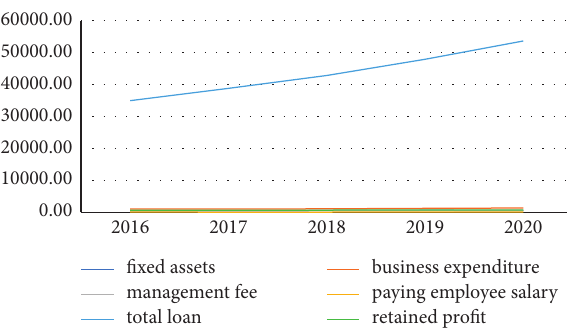
Figure 2: Changes in each variable over five years.